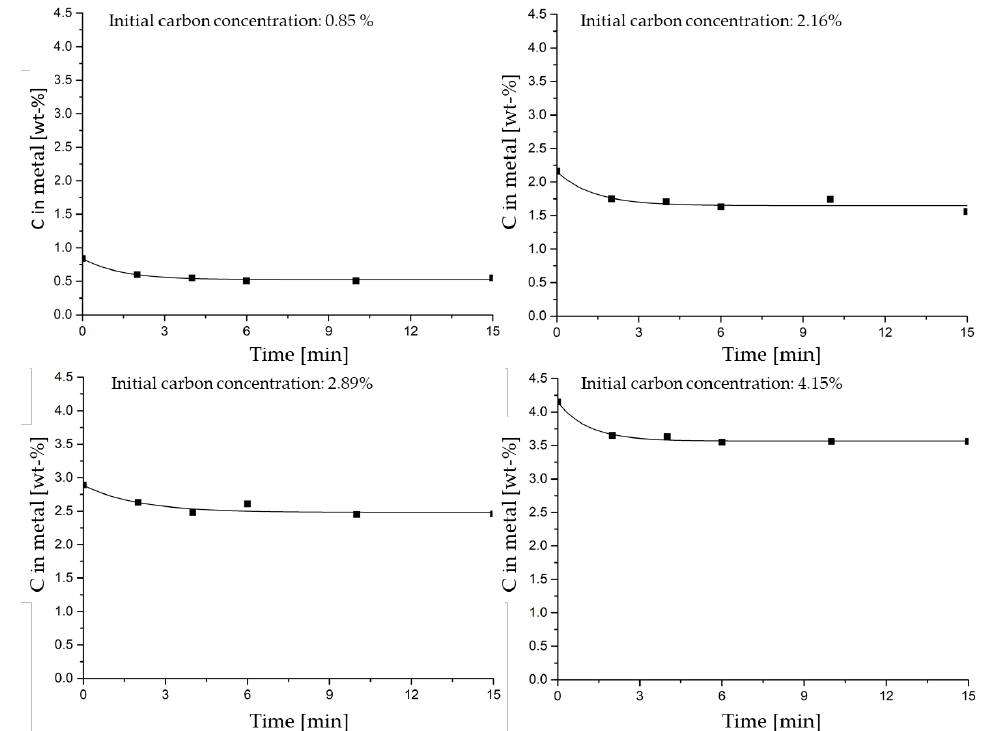
Figure 5. Changes in carbon concentration in the molten iron.